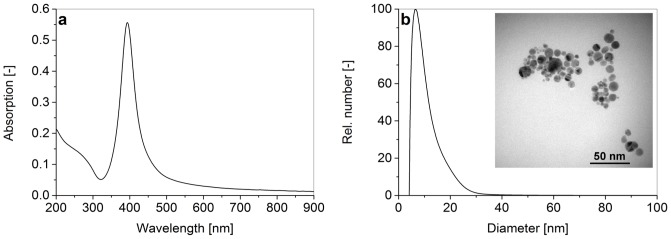
a) Absorption spectrum and b) size distribution data from analytical disc centrifugation of laser-generated silver nanoparticles with an exemplary TEM micrograph (insert).